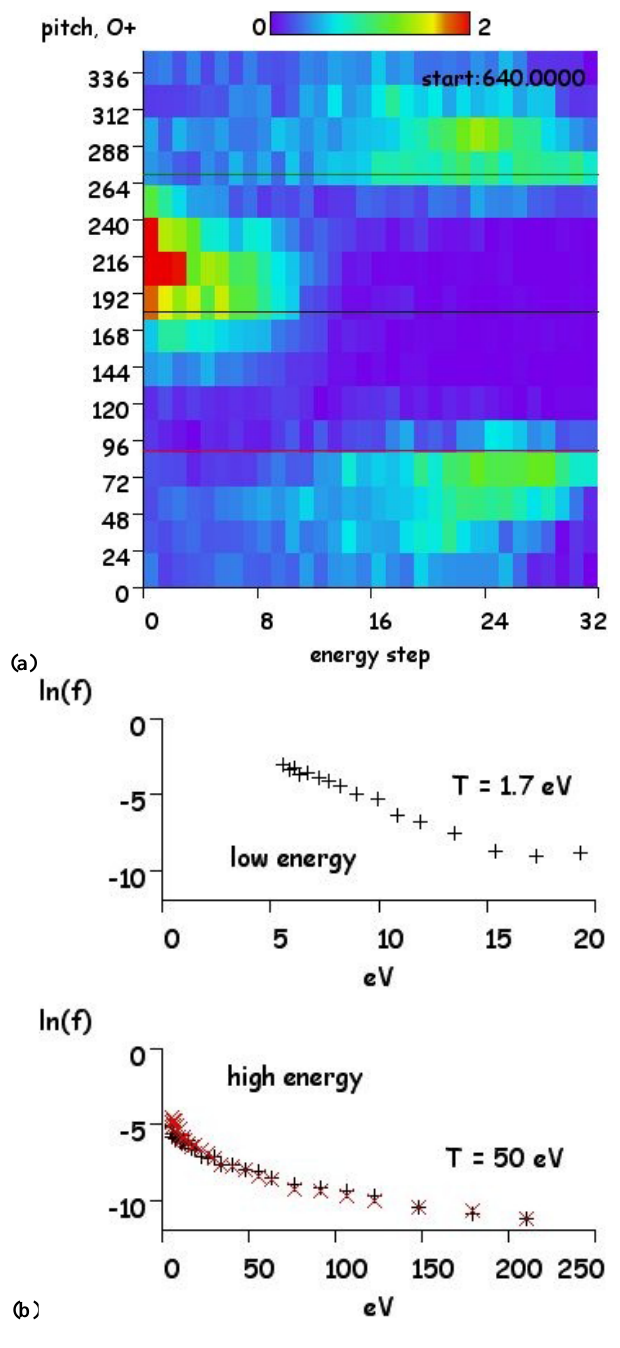
Fig. 3. (a) Example of oxygen pitch-energy distribution. (Color bar proportional to differential energy flux eV/cm 2 /s/sr/eV, arbitrary gain; as a function of pitch angle [deg] and energy step number of the logarithmic sweep.) (b) Plots of distribution function slope at 210 ◦ (top) and 70 ◦ (bottom). (Distribution function, /cc/(km/s) 3 , arbitrary gain, as a function of energy,